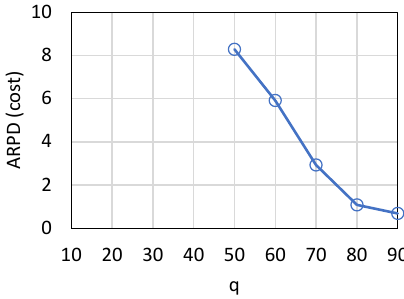
Figure 6. Comparison under varying q .